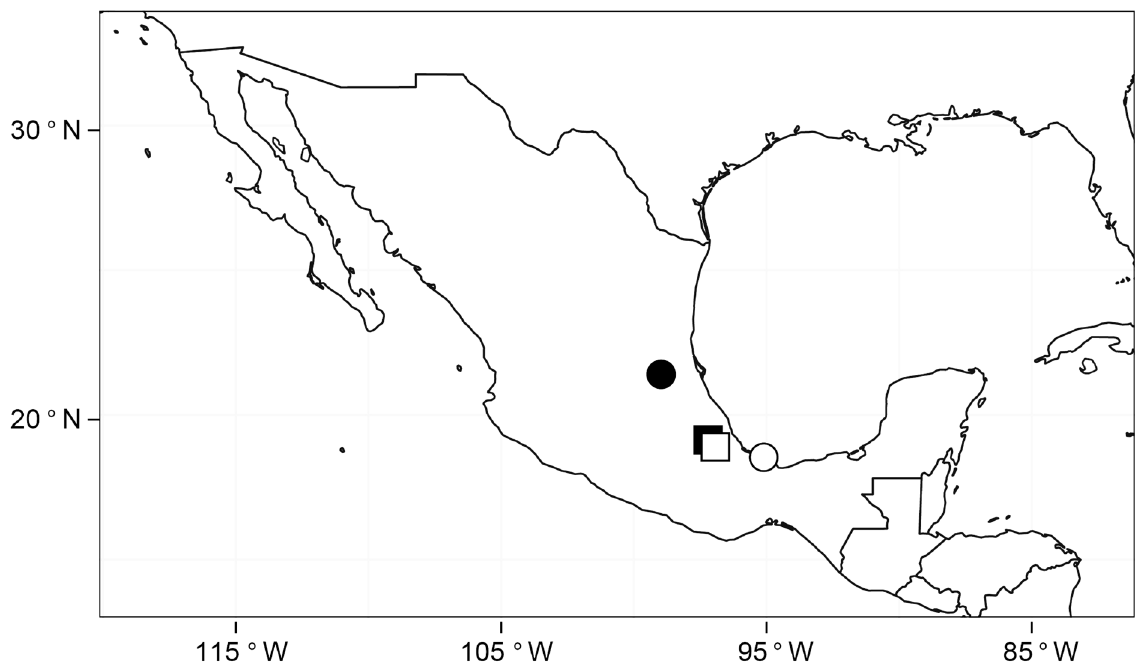
Fig. 52. Localities for the species of Anyphaena . Black square = Atotonilco Plots I and II, separated by 400 m, nine species registered: A. bifurcata sp. nov., A. bromelicola Platnick, 1977 (ON619634- 38 Supp. file 1), A. catalina Platnick, 1974 (ON619673-75), A. dulceae sp. nov., A. epicardia square = Xamaticpac Plots I and II, plots contiguous, eleven species registered: A. adnani sp.